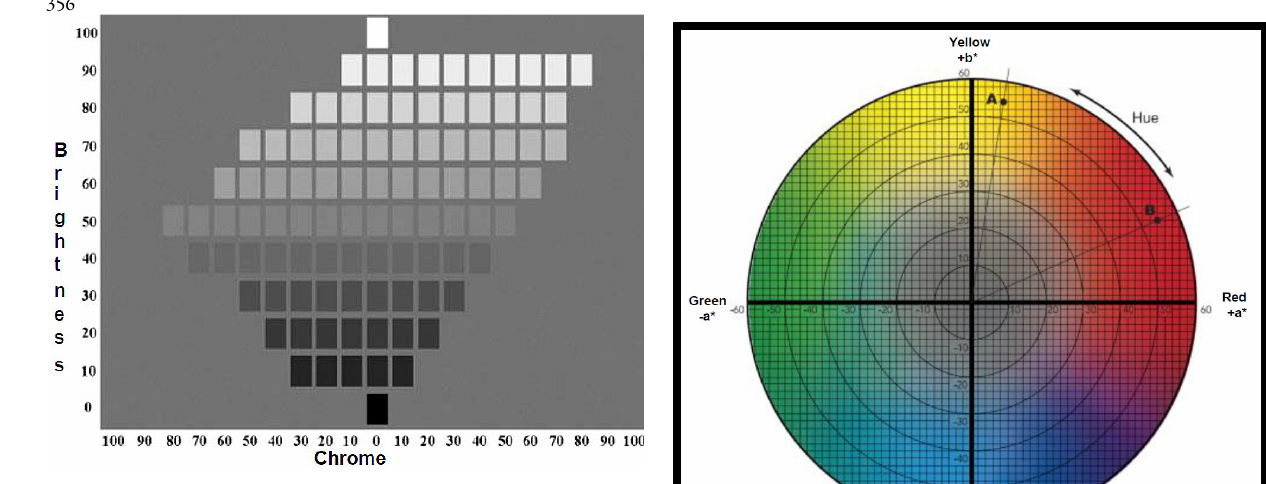
Fig. 3. Brightness - chrome diagram